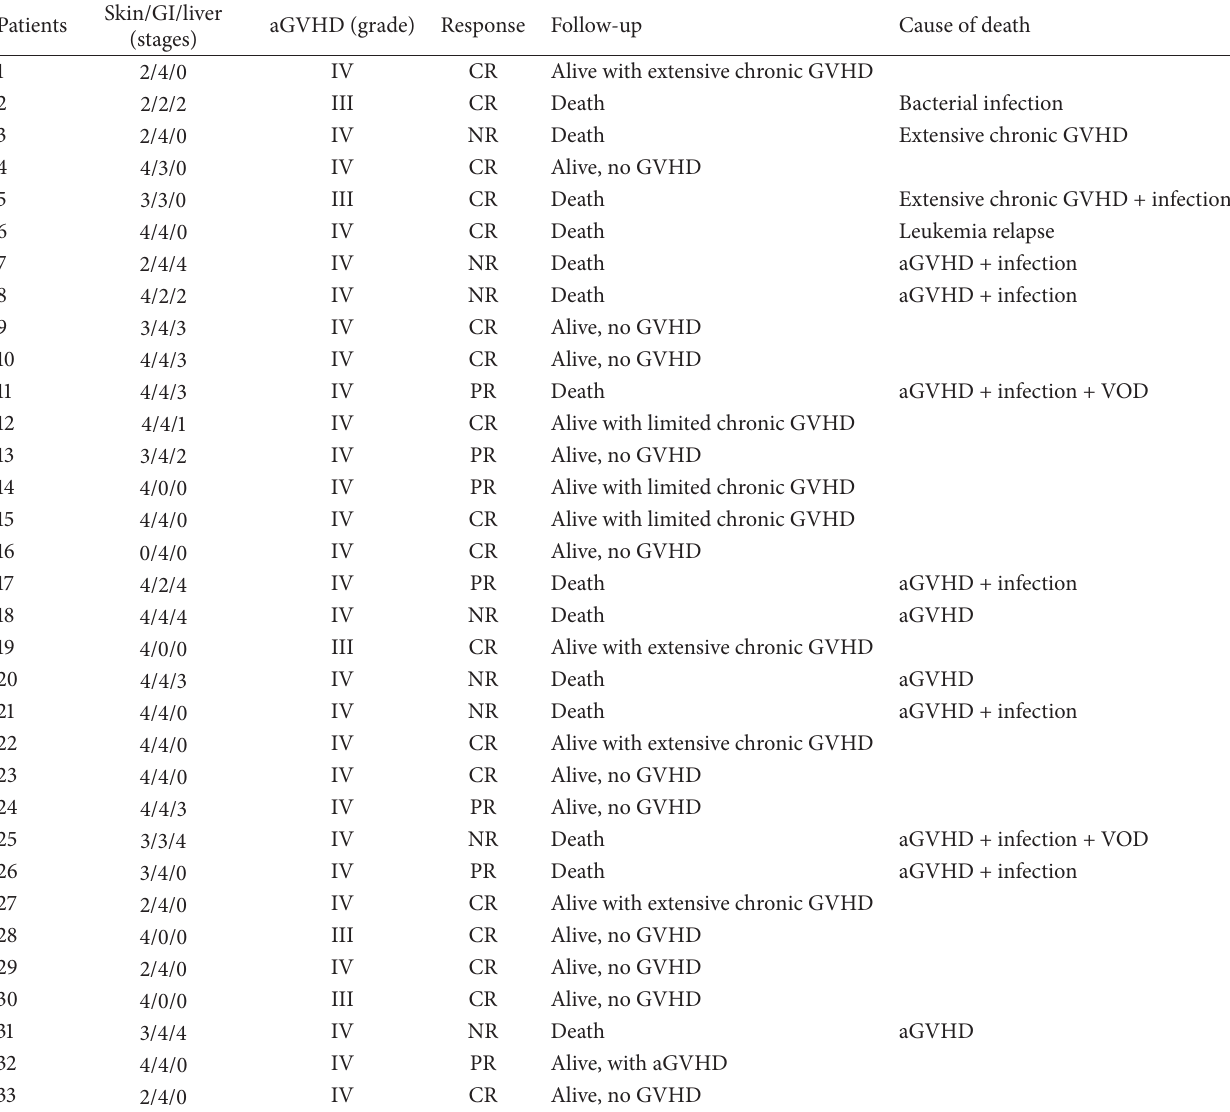
Table 2: Characteristics of GVHD and response to MSC